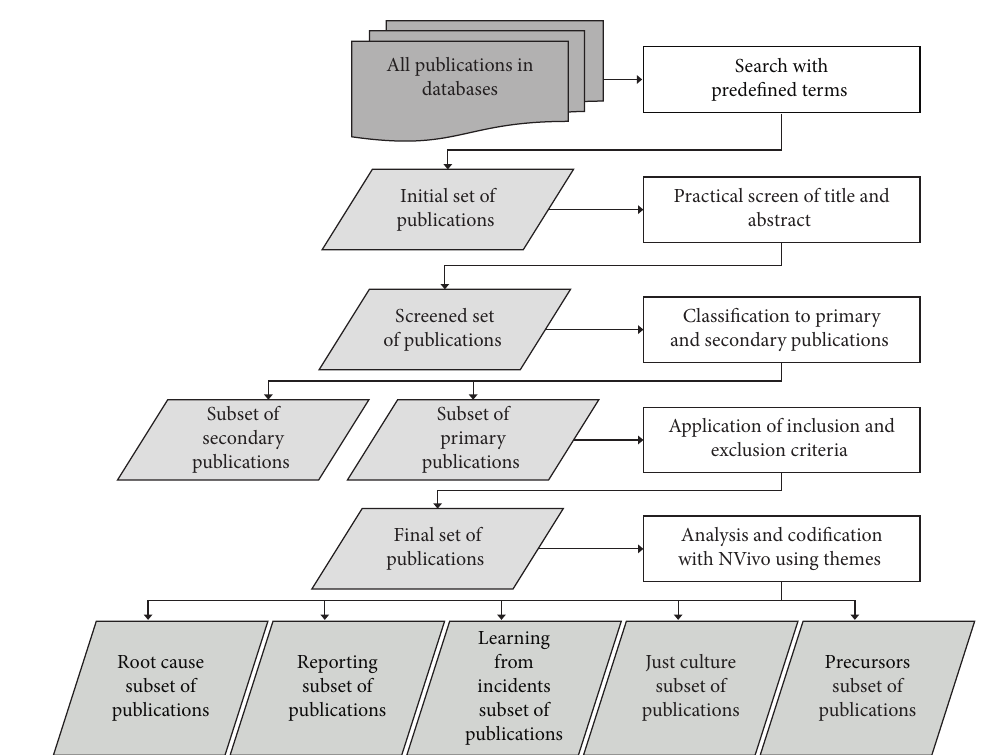
Figure 1: Flowchart of the overall document screening process and associated steps utilised in the systematic